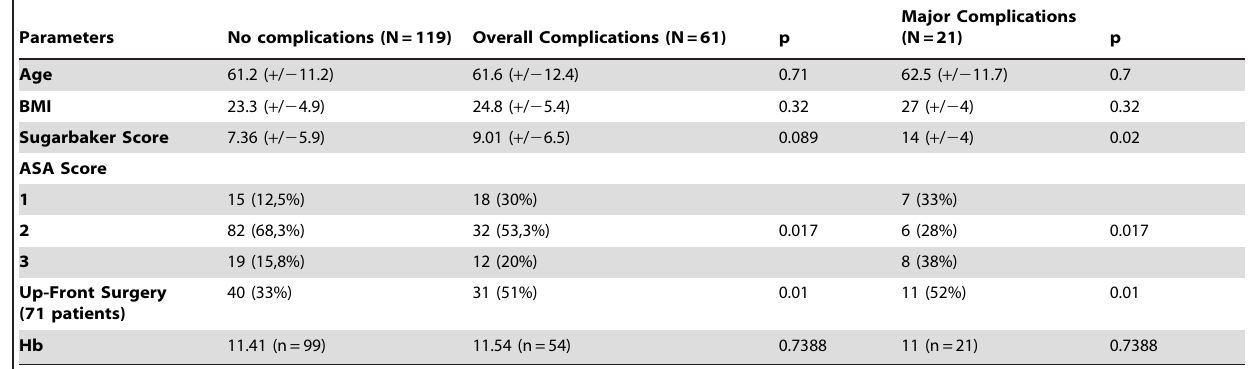
Table 5. Univariate analysis of factors associated with complications.